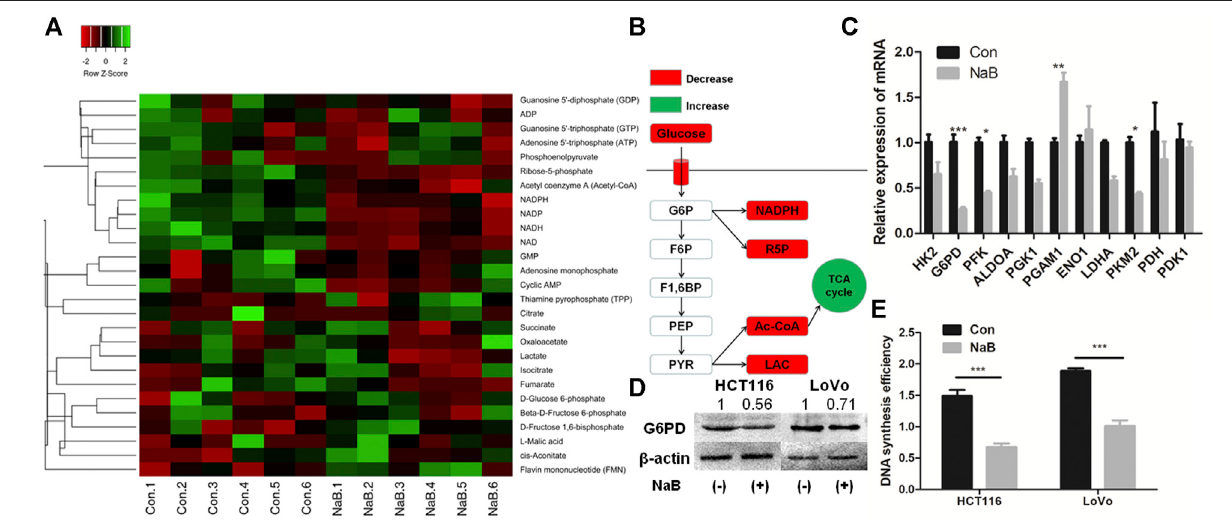
FIGURE 3 | Butyrate suppressed G6PD abundance and DNA synthesis of colon cancer cells. (A) The concentration of intracellular metabolites associated with glucose metabolism in HCT116 cells being incubated with 2 mM butyrate (labeled as “ NaB ” ) or PBS vehicle (marked as “ Con ” ) for 24 h were measured by liquid chromatograph-mass spectrometer/mass spectrometer (LC-MS/MS). (B) The variation of central metabolites in HCT116 cells being incubated with 2 mM butyrate or PBS vehicle for 24 h was annotated in the schematic diagram of glycolysis pathway. (C) After HCT116 cells were incubated with 2 mM butyrate for 24 h, the expression levels of genes that regulate glucose metabolism were analyzed by qPCR. ( D) The protein levels of G6PD in HCT116 and LoVo cells after being treated with 2 mM butyrate for 24 h were tested by western blotting. (E) After incubating HCT116 and LoVo cells with 2 mM butyrate or PBS vehicle for 24 h, DNA synthesis ef fi ciency in both cell lines was measured by BrdU incorporation assay. The error bars showed standard deviations from independent triplicates. * p < 0.05, ** p < 0.01, *** p < 0.001. G6P, D-Glucose 6-phosphate; F6P, Beta-D-Fructose 6-phosphate; F1,6BP, D-Fructose 1,6-bisphosphate; PEP, Phosphoenolpyruvate; PYR, Pyruvate; LAC, Lactate; R5P, Ribose-5-phosphate.